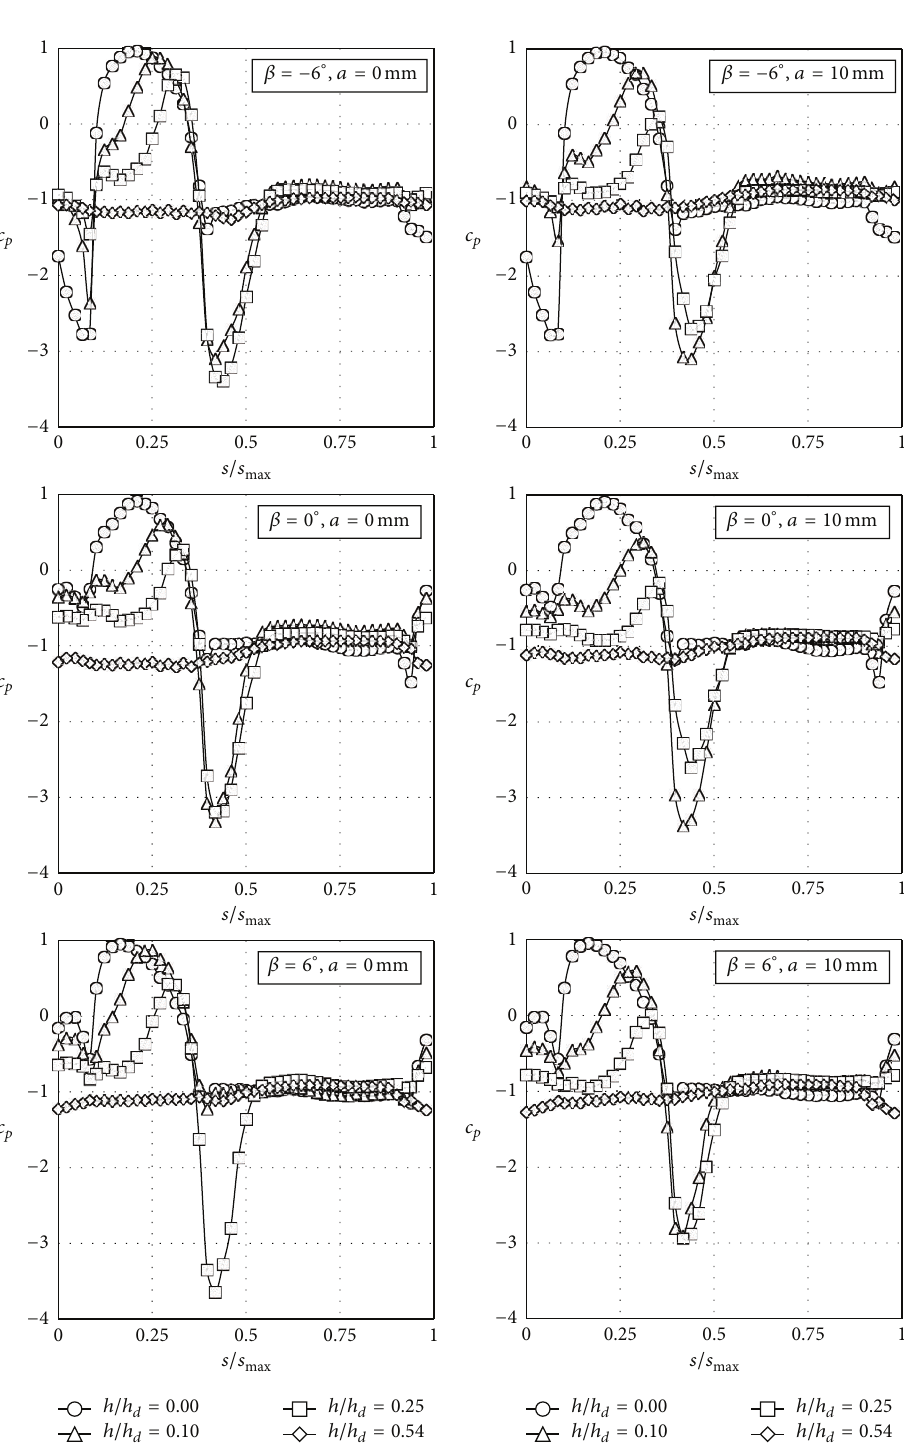
correlation between the rolling moment coefficient and